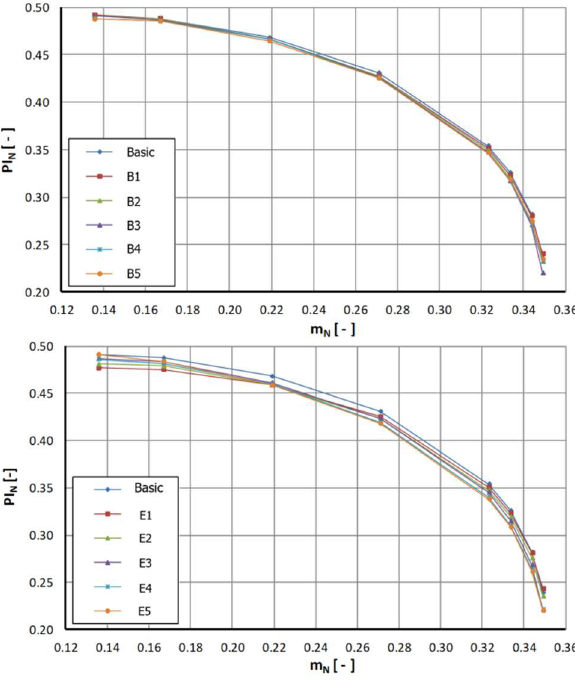
Fig. 7. The influence of the hole to the pressure ratio .